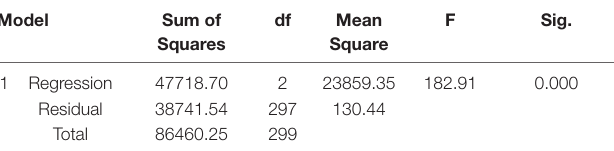
TABLE 7 | ANOVA for WE, SE, and CE.